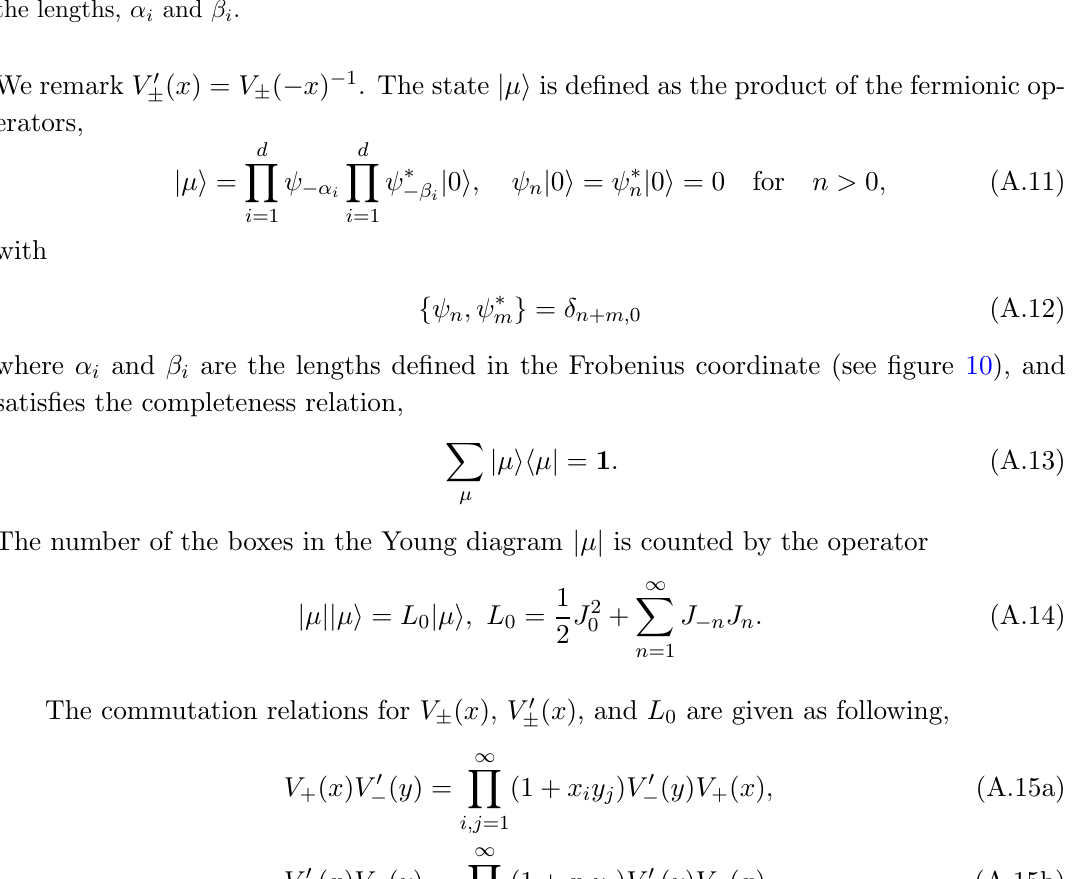
Figure 10 . The Frobenius coordinate. By drawing the diagonal line, we can de(cid:12)ne two kinds of the lengths, (cid:11) i and (cid:12) i